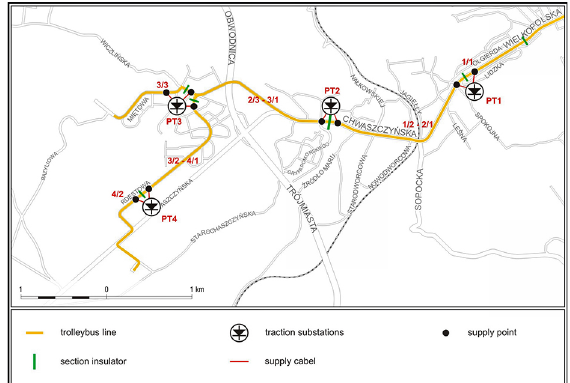
Fig. 4. Example of decentralized supply system, bilateral